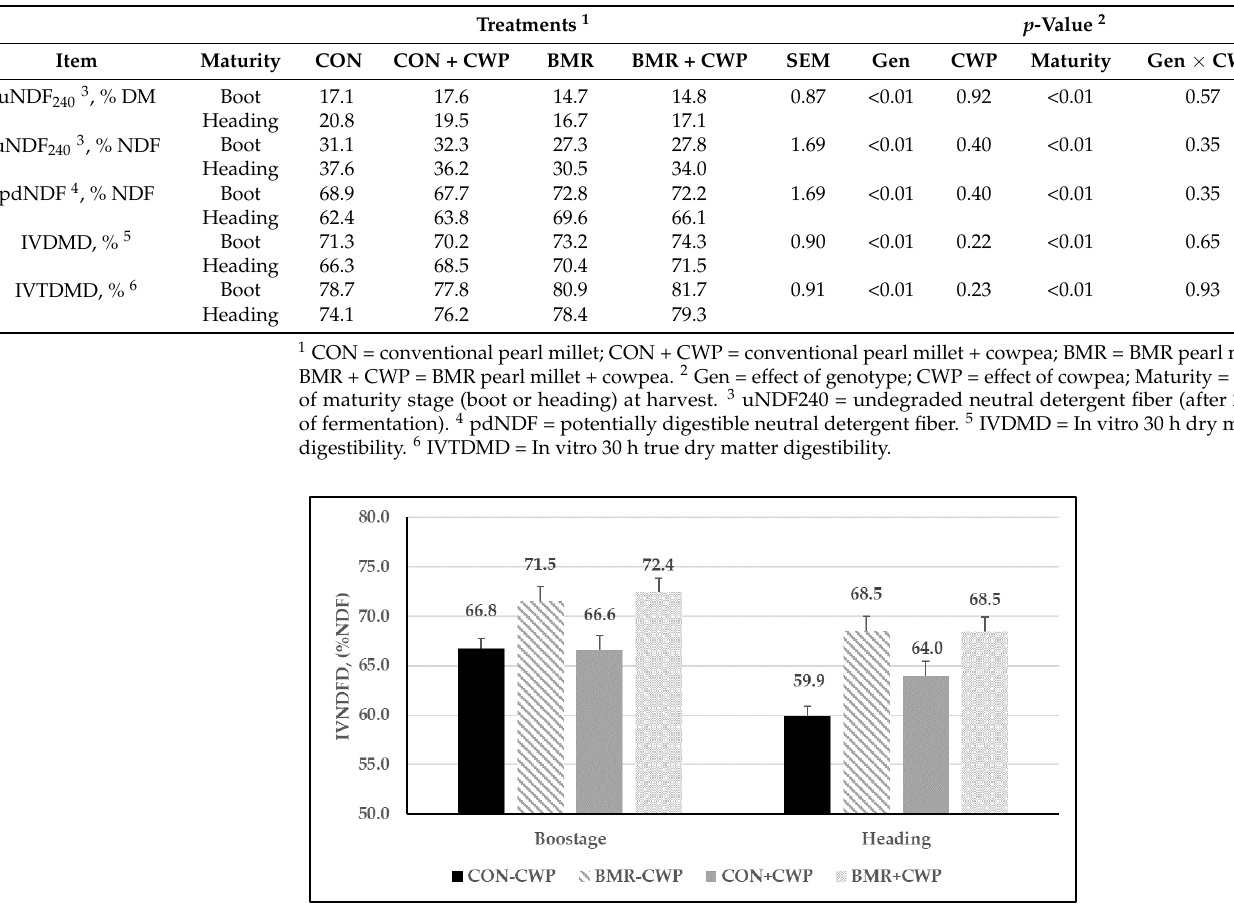
Figure 4. In vitro NDF digestibility (IVNDFD) of pearl millet genotypes mixed or not with cowpea and harvested at boot or heading maturity stages in 2019 (Trial 2). Gen ( p < 0.01), CWP ( p = 0.22), maturity ( p < 0.01), and Gen × CWP ( p = 0.43); vertical bars indicate standard errors of the mean.